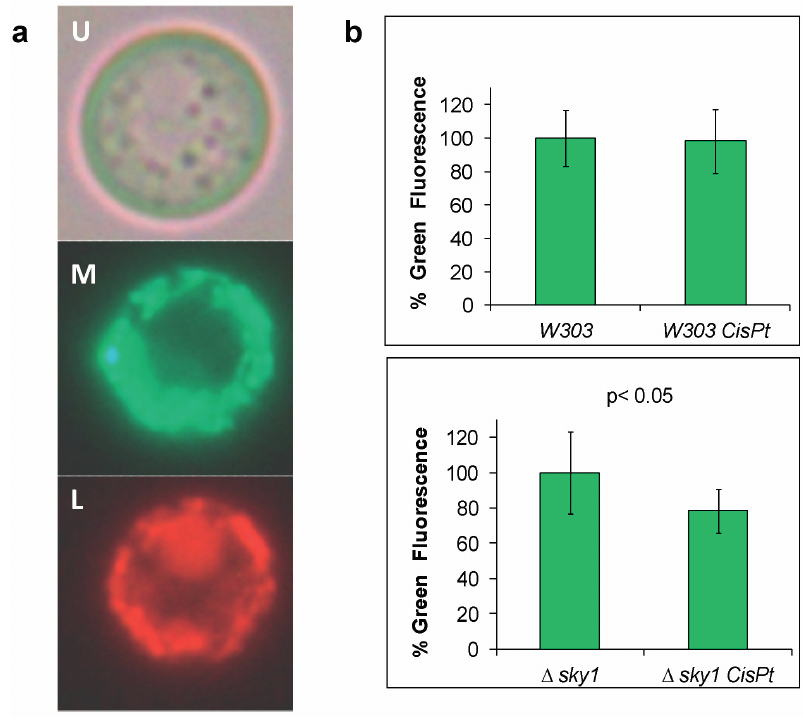
Figure 4. Mitophagy in W303-1A ( W303 ) and ∆ sky1 strains after cisplatin ( cisPt ) treatment. ( a ) Visualization (objective 100×) of mitophagy in W303 cells treated with 1200 µM cisplatin; U, Bright field; M, Green channel for phluorin; L, Red channel for the Ds. Red T3 protein; ( b ) Quantification of the green